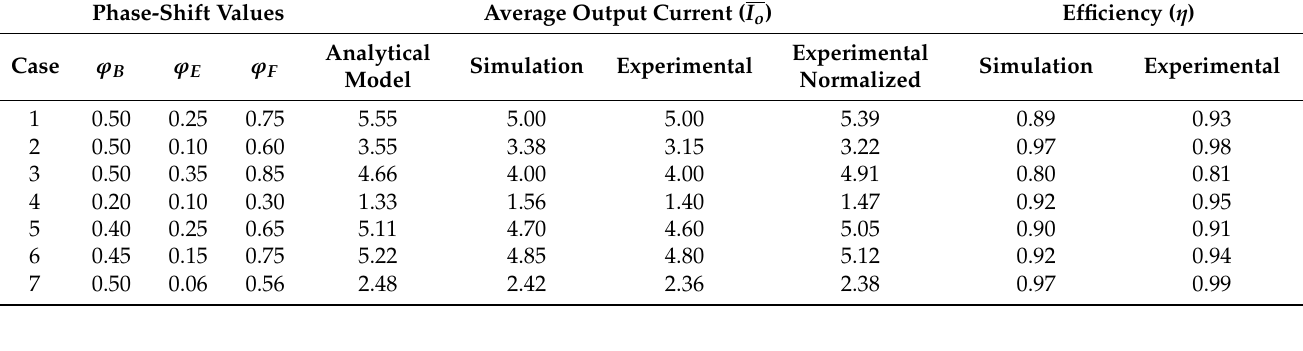
Table 3. Comparison of average output current with different combinations of phase-shift values.